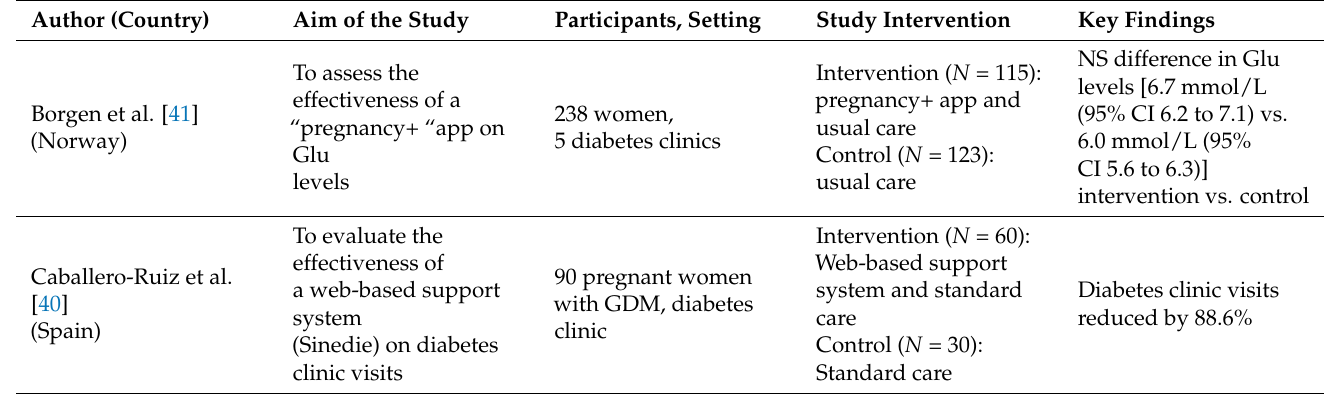
Table 3. Overview of randomised controlled trials reporting on the effectiveness of digital tools to support dietary self-management of